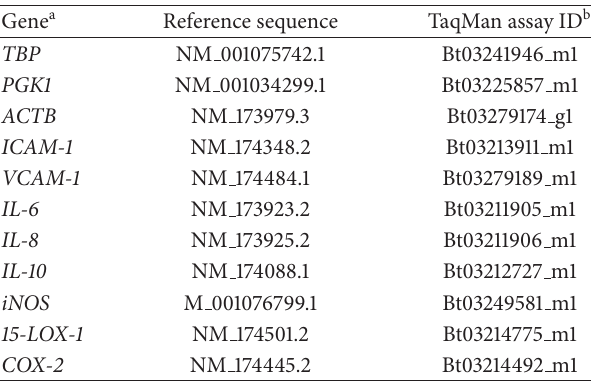
Table 1: Bovine primers for